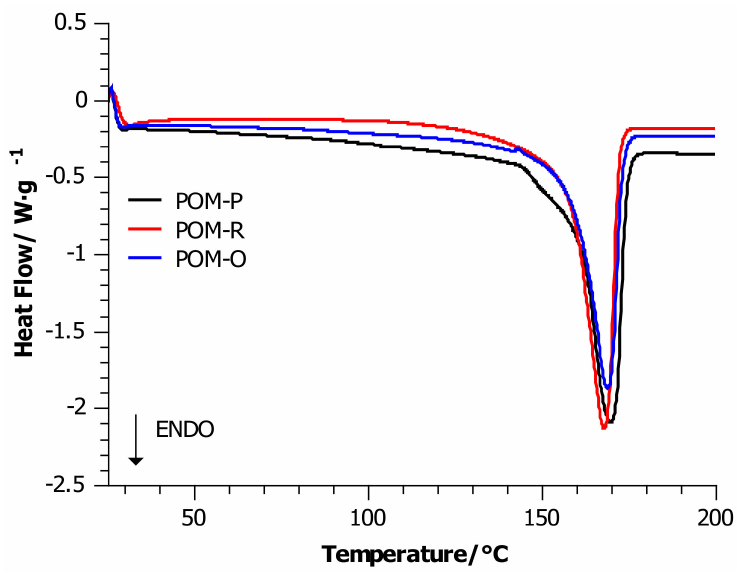
Figure 1. DSC heating curves for POM-P, POM-R, and POM-O samples.